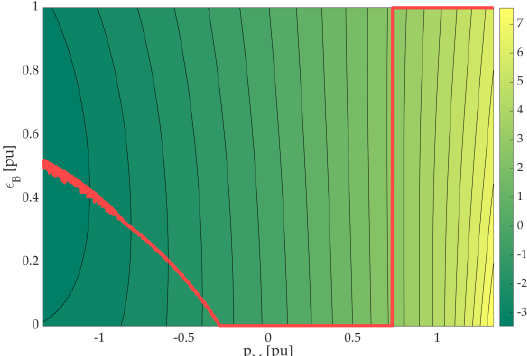
Figure 9. The optimal φ locus (in $/h) on the ( p M , ε B ) plane, together with the optimal ( p M , ε B ) trajectory (in red).